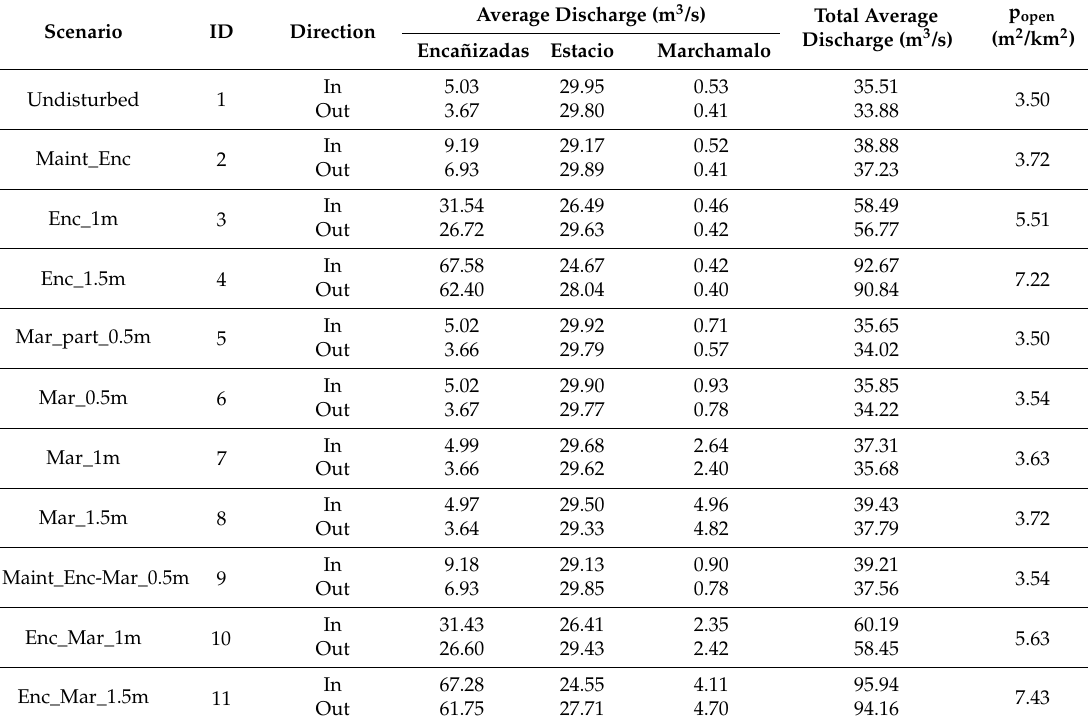
Table 5. Individual and total average discharge for the channel inlets (annual